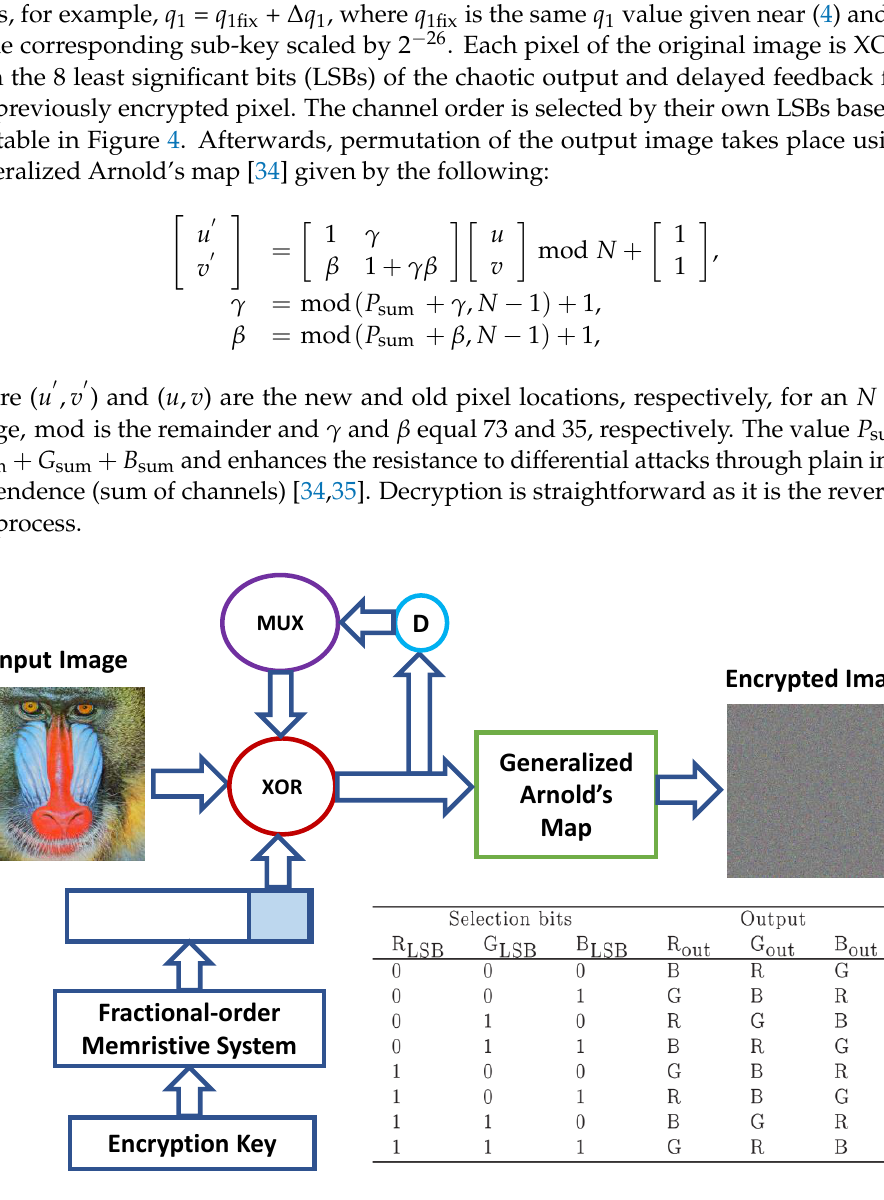
Figure 4. Encryption scheme and multiplexing